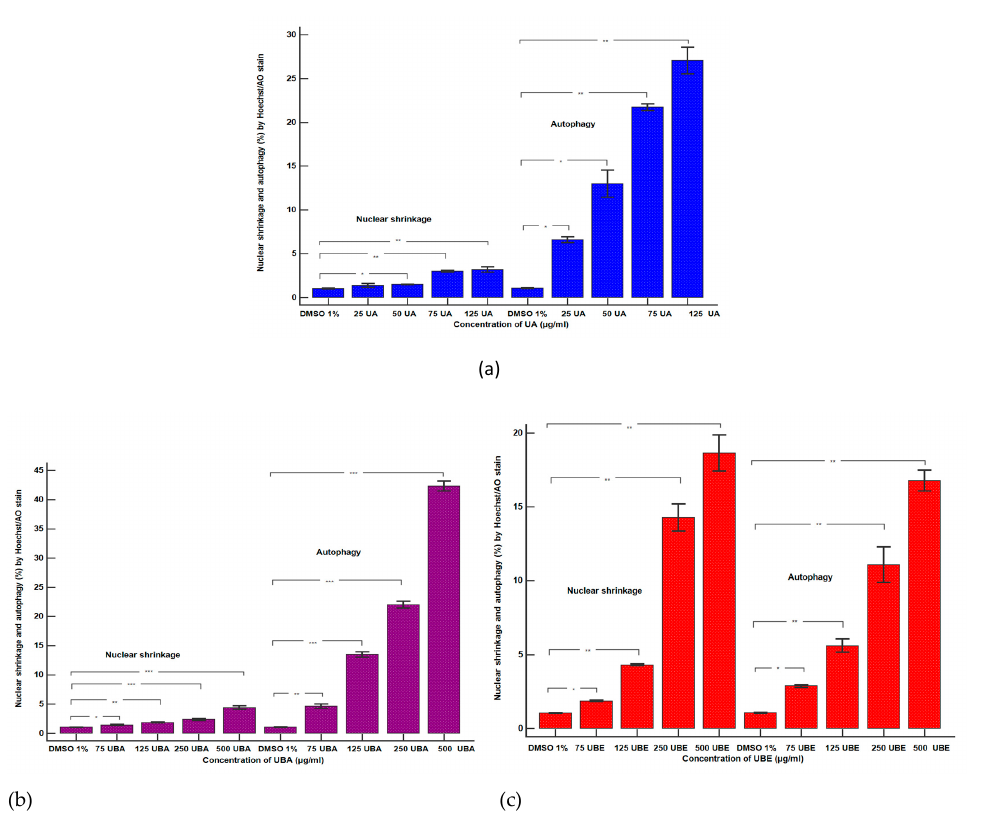
Figure 8. Statistical analysis of nuclear shrinkage and autophagy: ( a ) UA; ( b ) UBA; ( c ) UBE. * p < 0.05. ** p ≤ 0.01, and *** p < 0.001 represent significant statistical differences between the control and samples made by paired samples t -test.